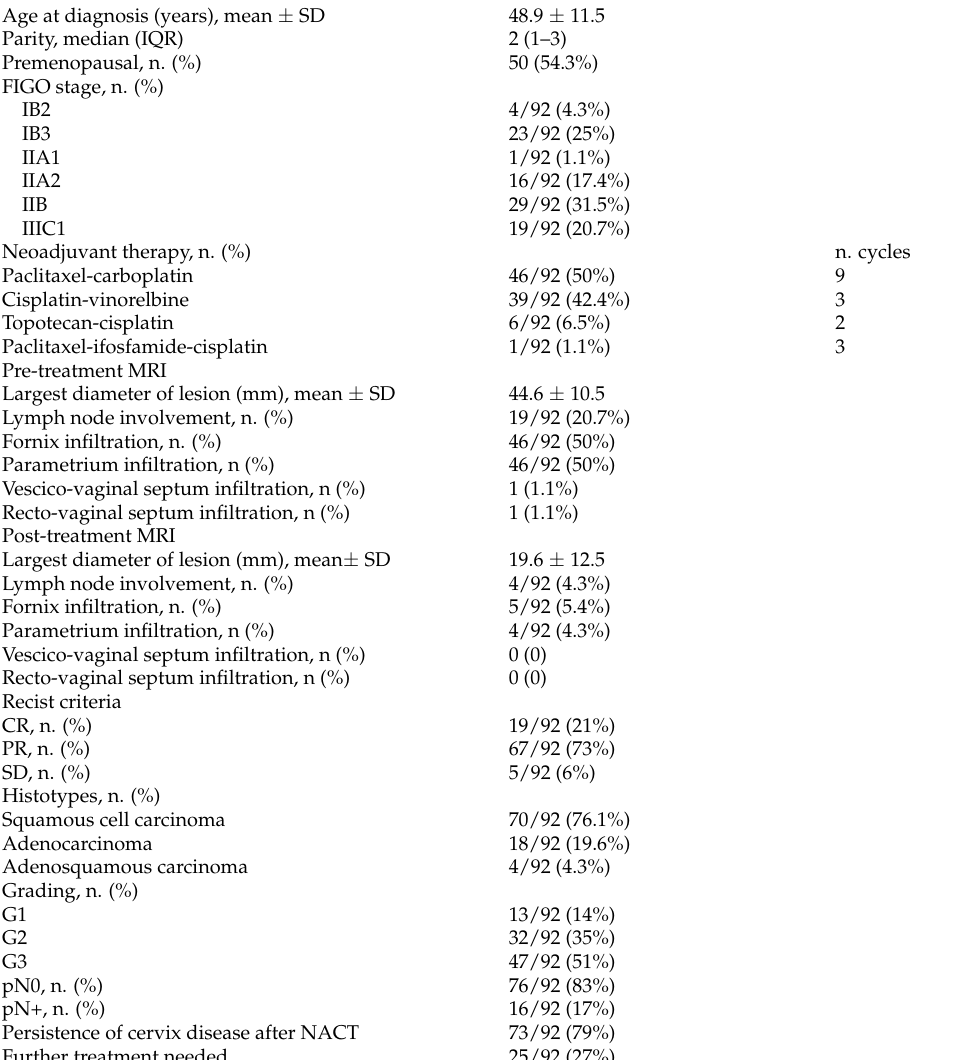
Table 1. Demographic and clinical data, MRI parameters and histological examination. Age at diagnosis (years), mean ±